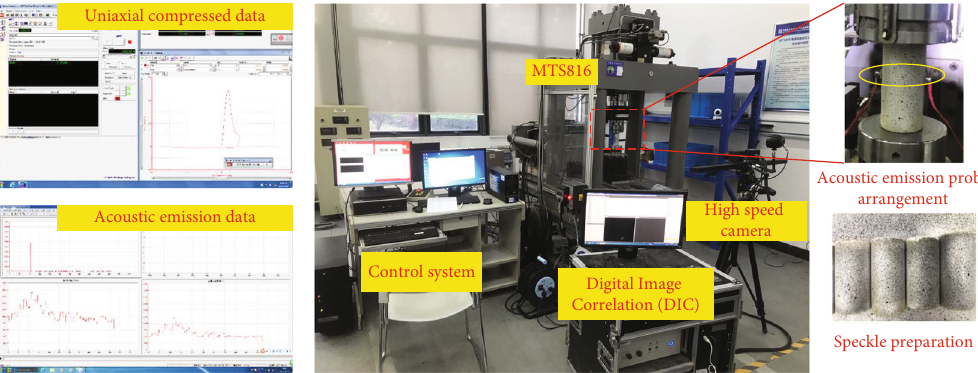
Figure 8: Uniaxial compression test system of weakly cemented rock sample.